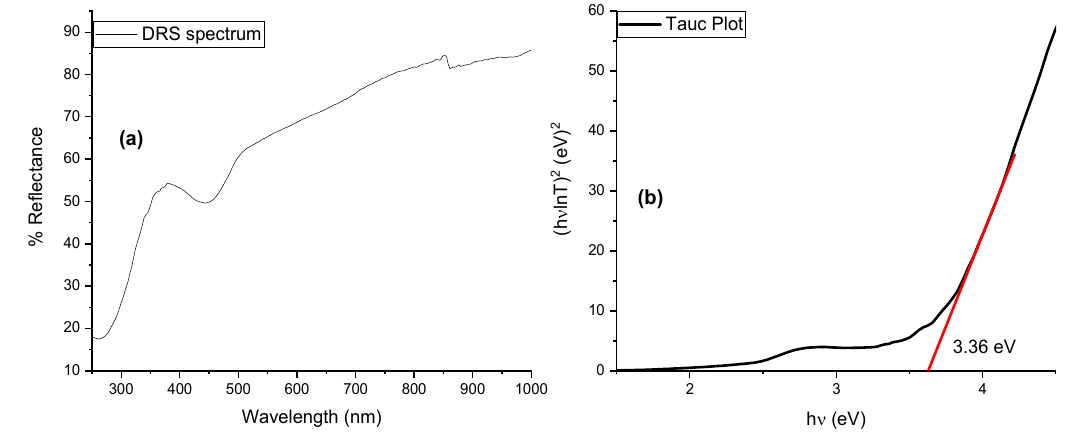
Table 2 . Optical band gap energy of SnO 2 nanoparticles .